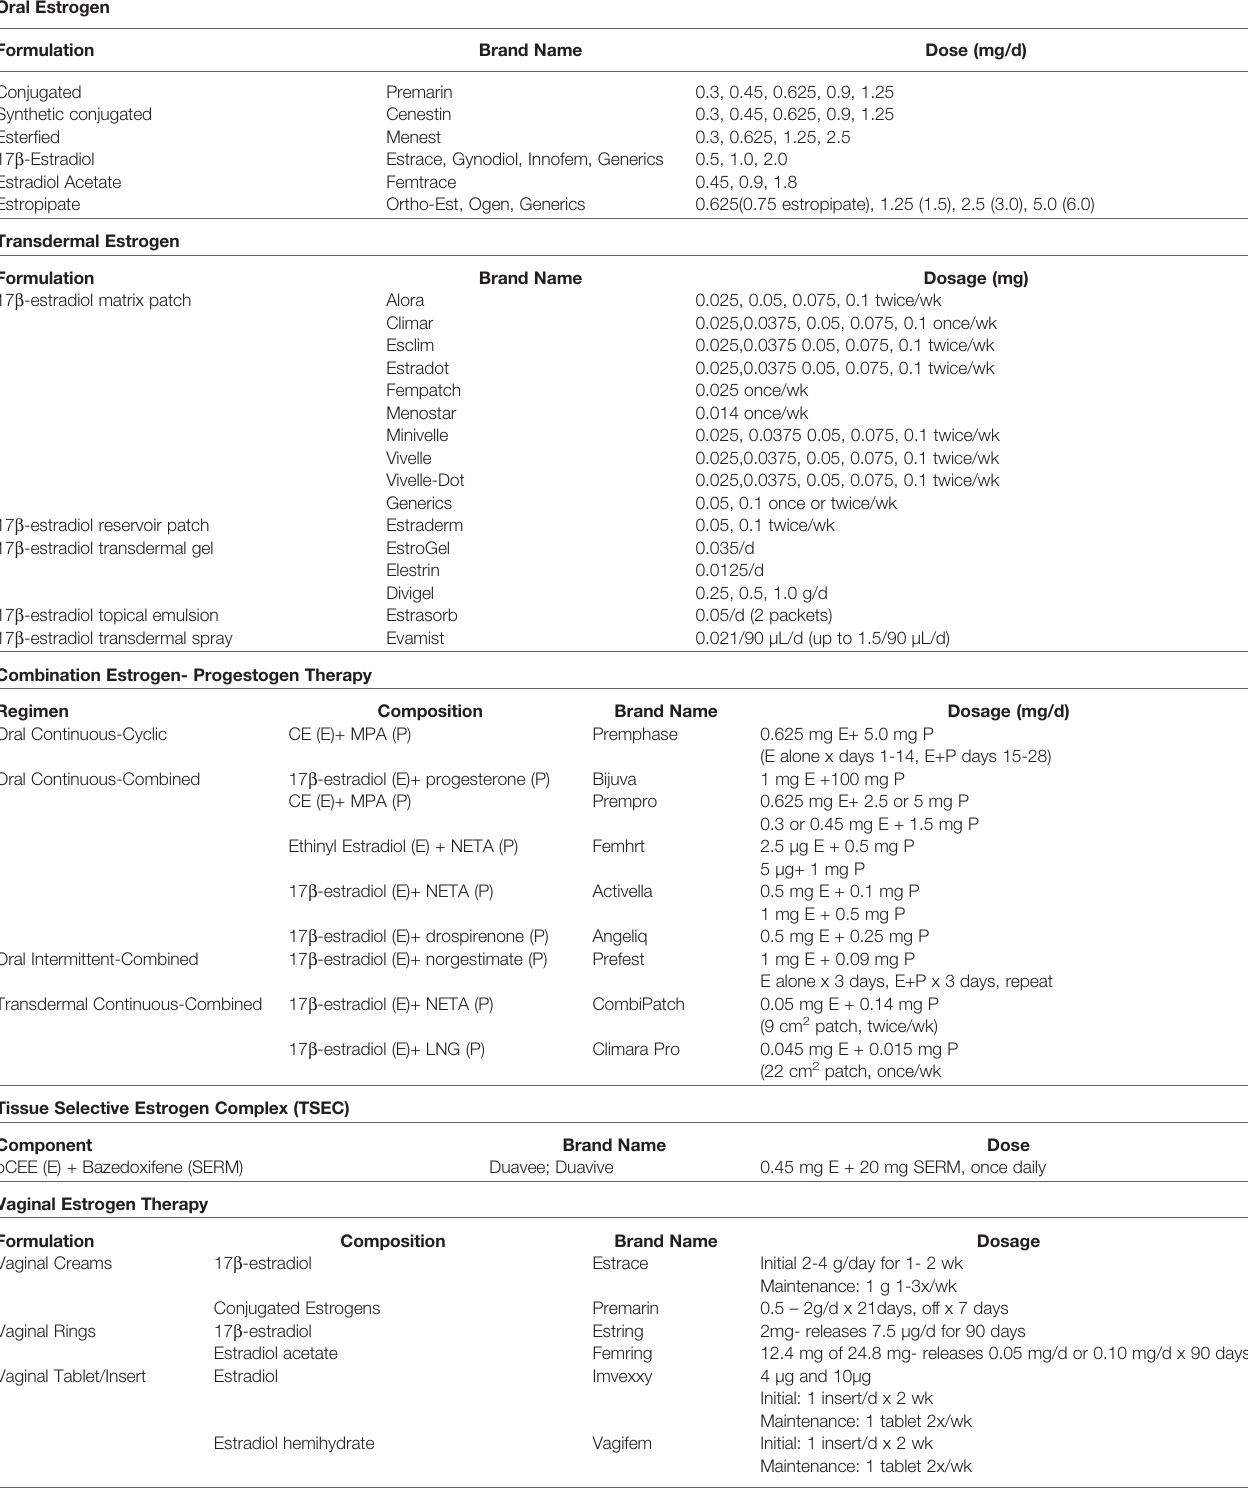
TABLE 2 | Menopausal hormone therapy by formulation and route available in the United States